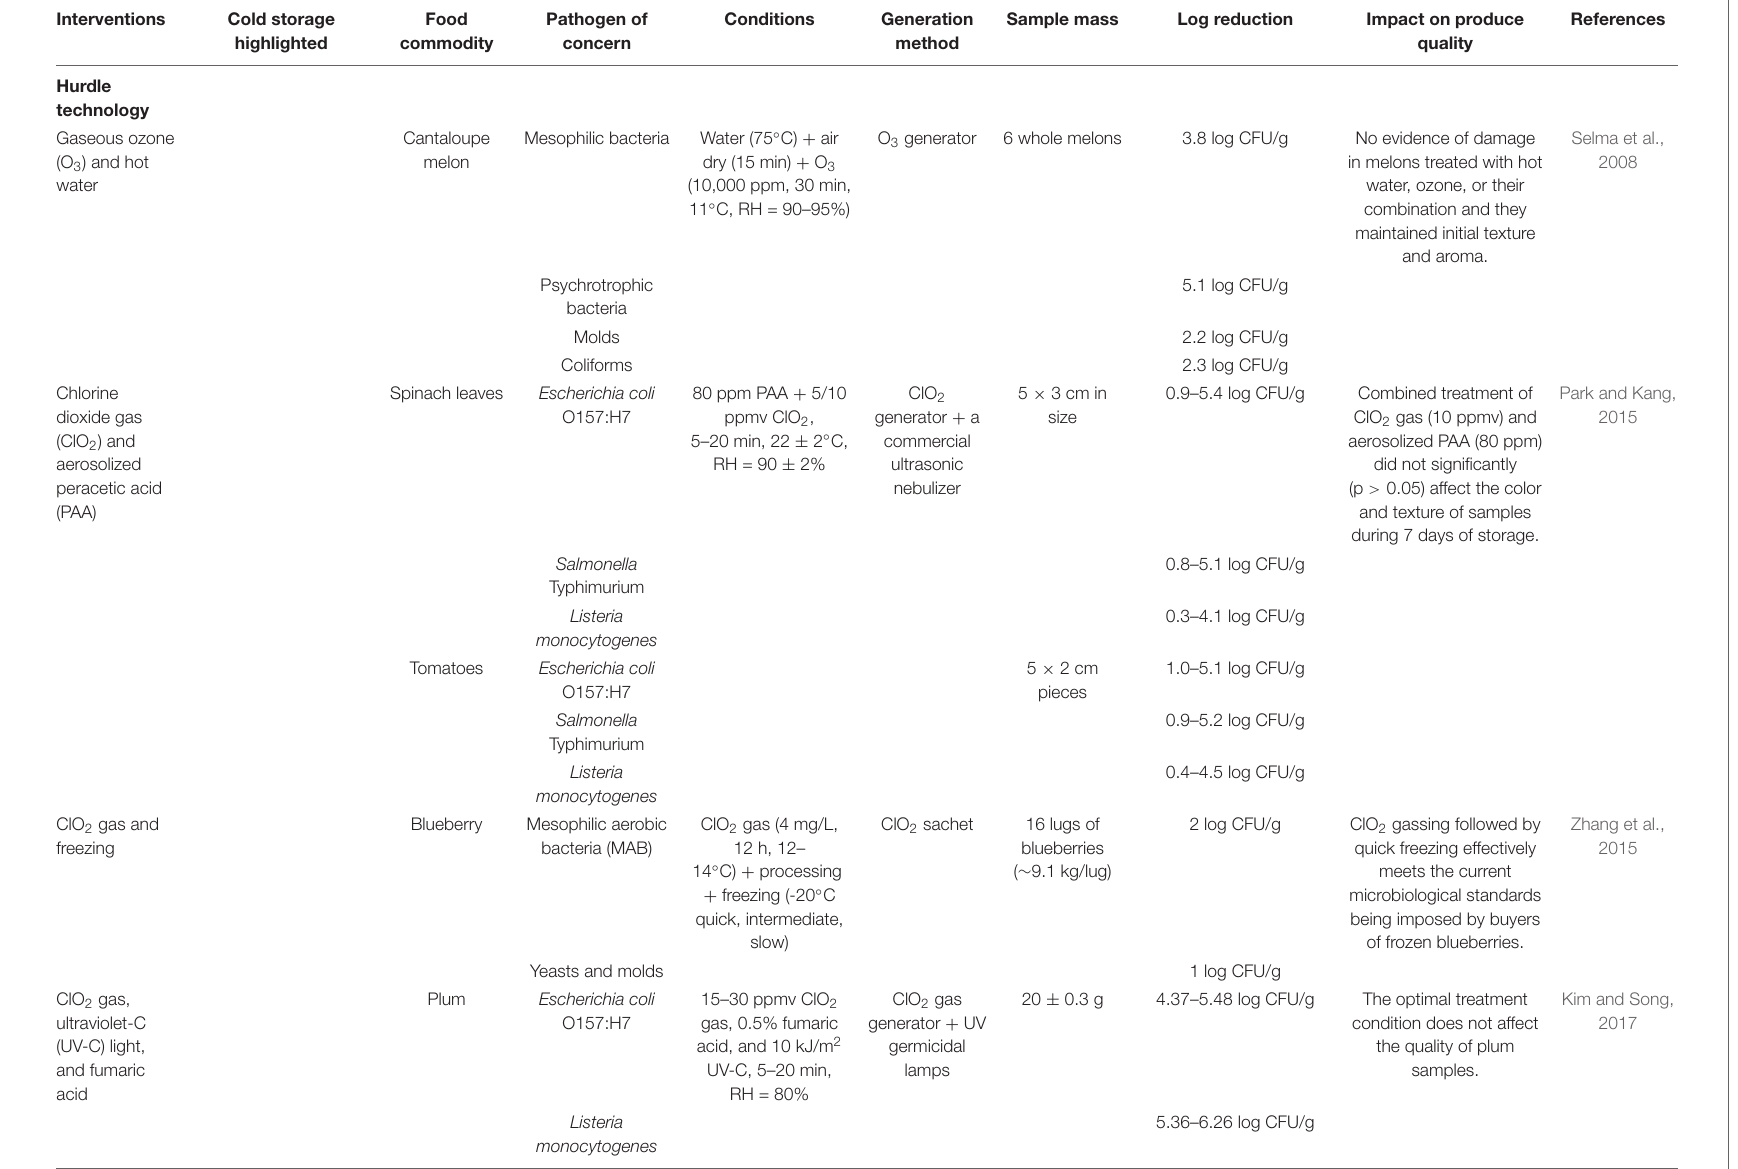
TABLE 2 | Hurdle technologies (gaseous intervention involved) for bacteria decontamination on produce.